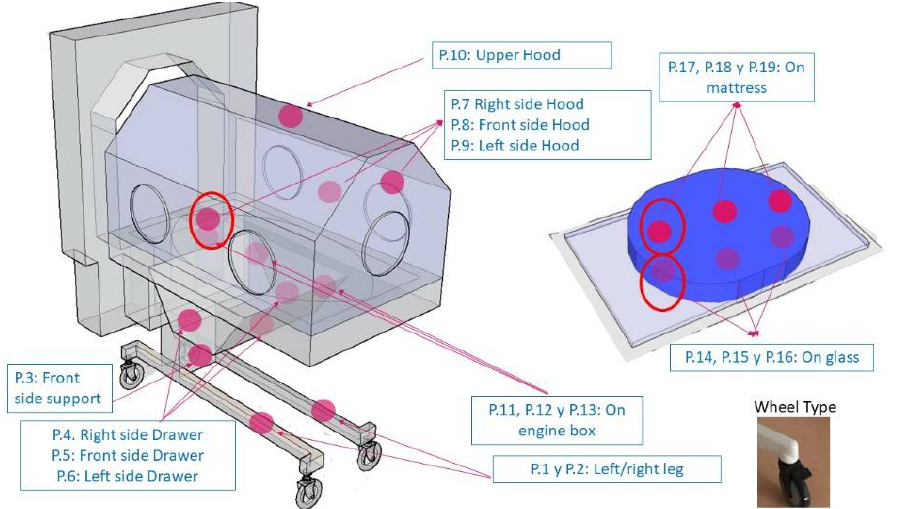
Figure 2. Positions of the recordings made in the incubator.